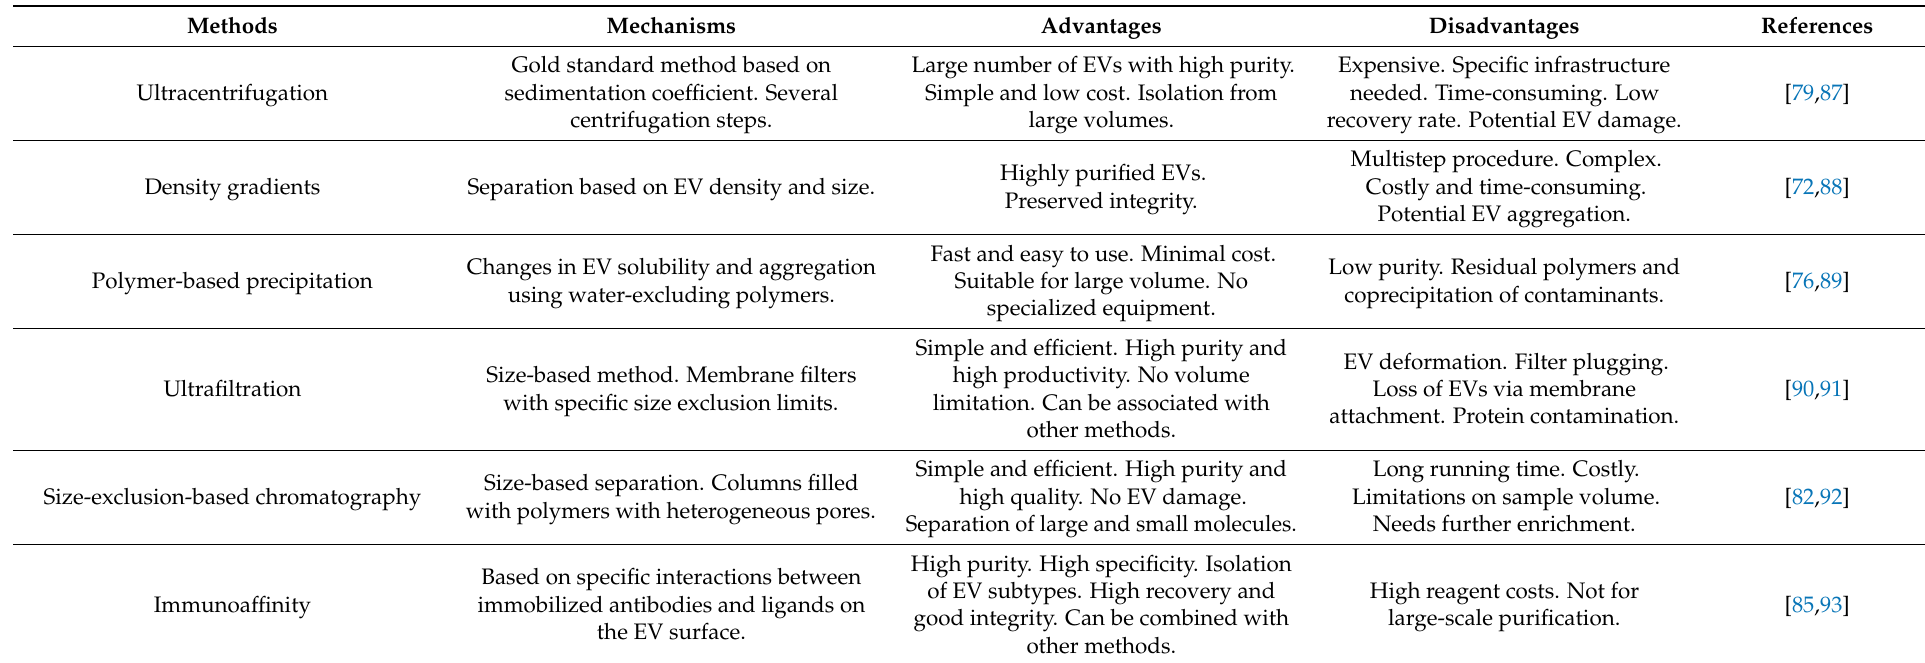
Table 1. Principal EVs isolation methods, advantages, and